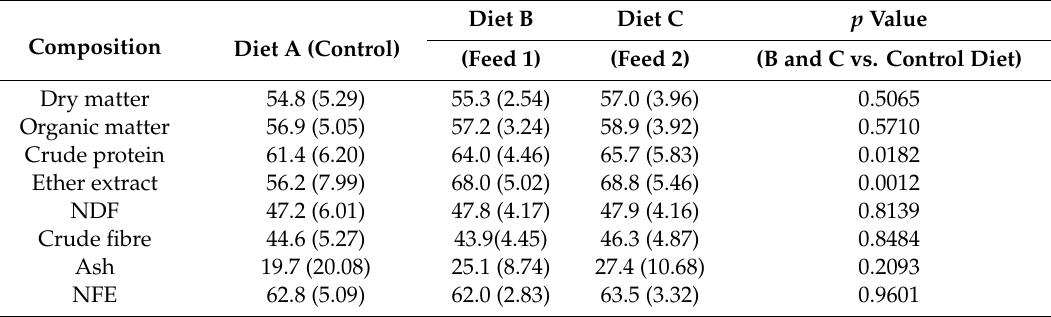
Table 5. Average apparent digestibility coe ffi cients (%) and standard deviations (s.d.) for the total diet nutrients in the control and experimental